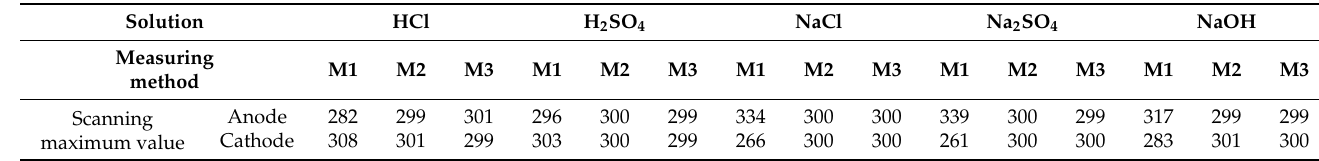
Table 1. Maximum anodic and cathodic current densities of Tafel curves using three methods in five solutions.